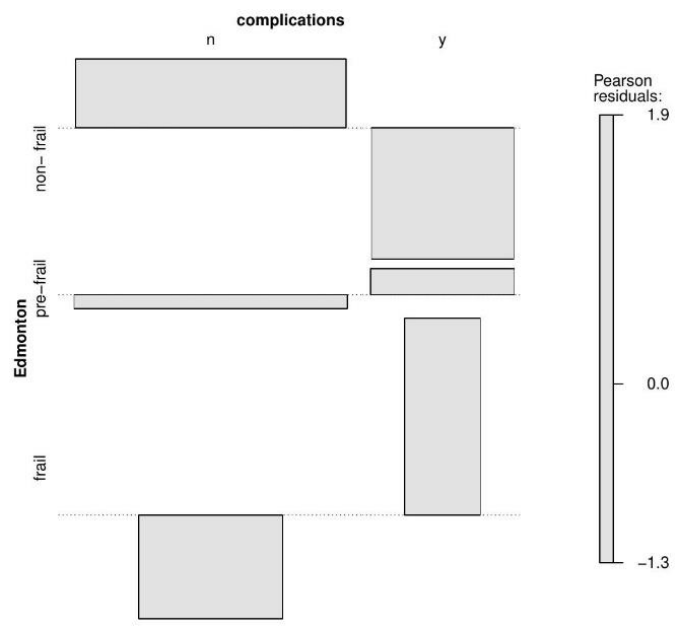
Figure 2. Association plot presenting the multidimensional relationship between Complications and Edmonton subgroups.